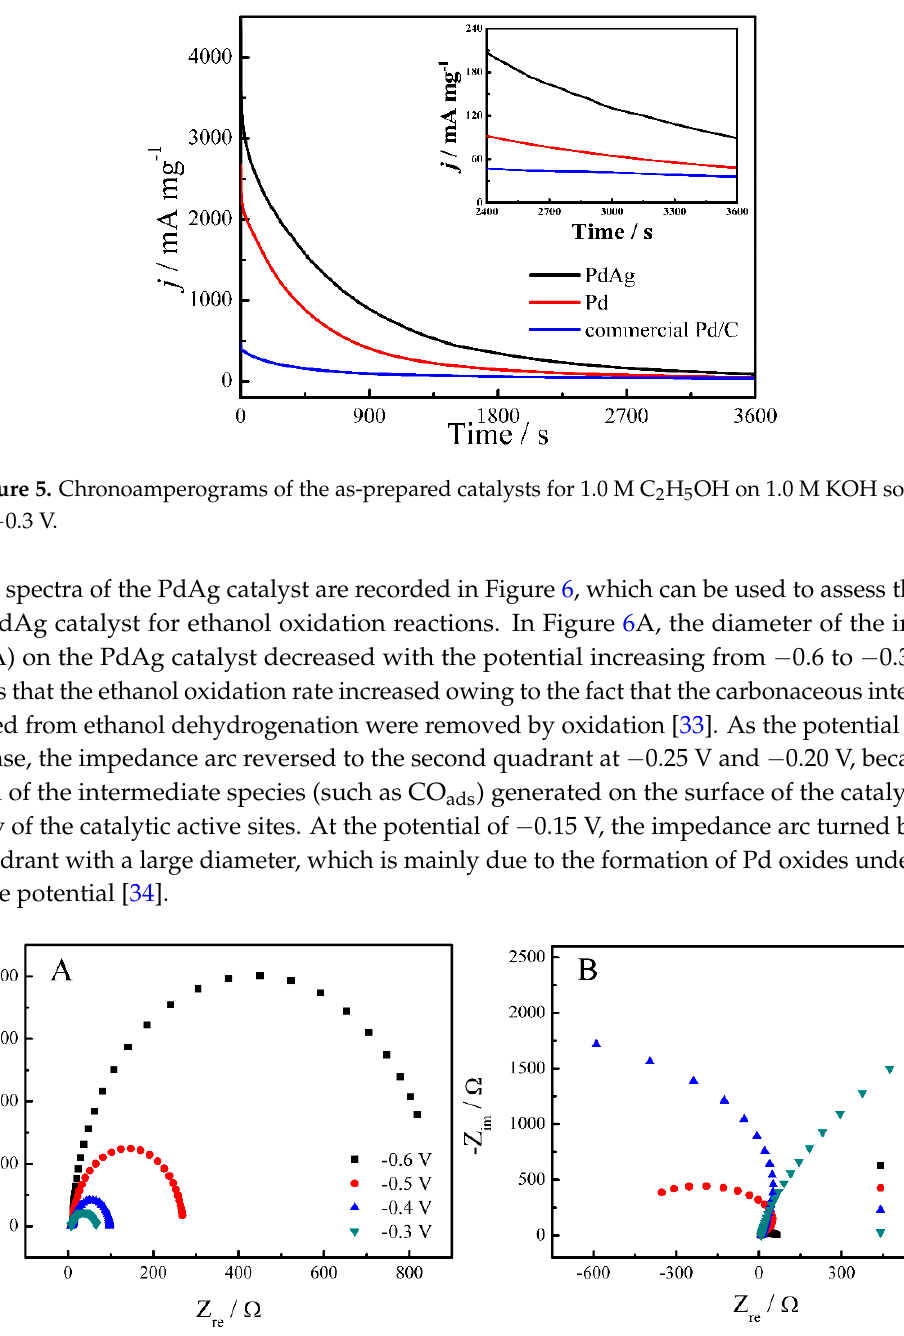
Figure 6. Nyquist plots of C 2 H 5 OH electrooxidation on the PdAg catalyst in 1.0 M C 2 H 5 OH + 1.0 M KOH solution with potential range of − 0.6 V to − 0.3 V ( A ), and − 0.3 V to − 0.15 V ( B ).